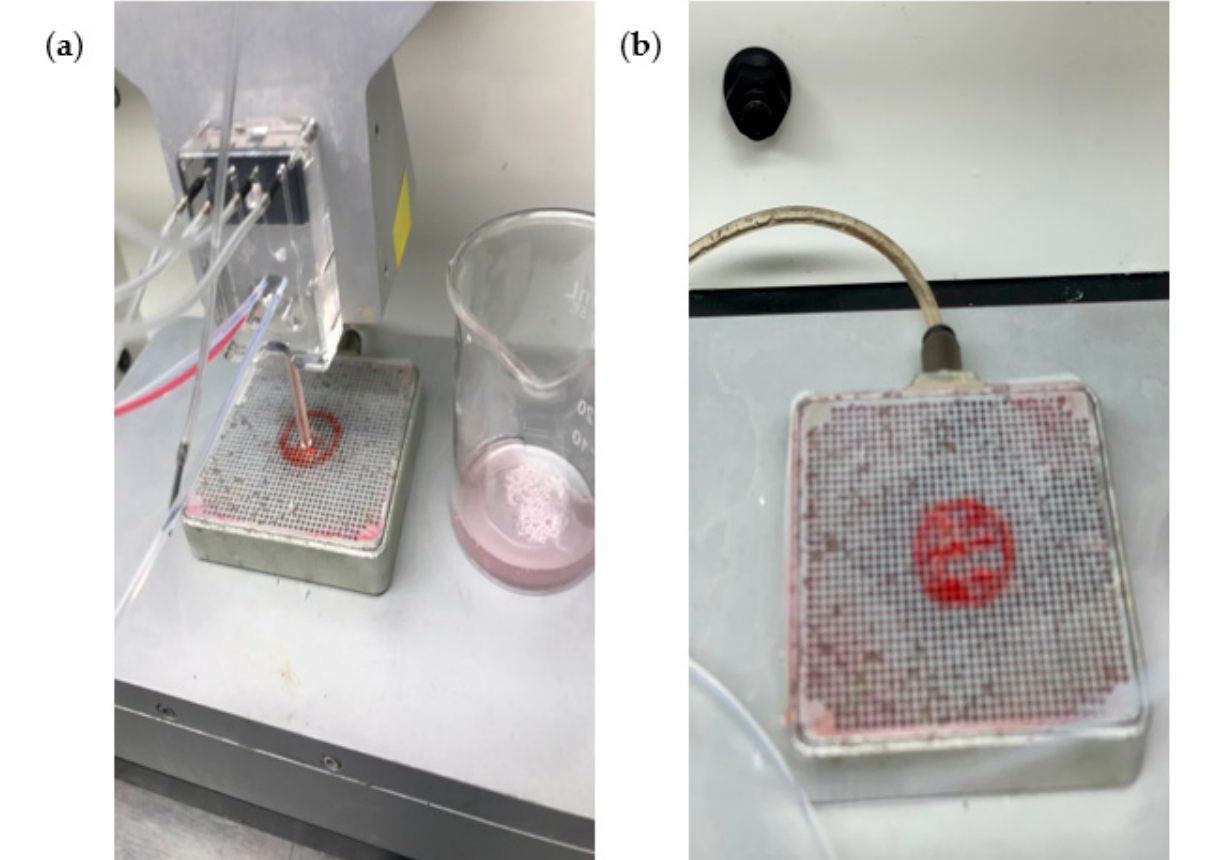
Figure 2. Bioprinted constructs consisting of fibrin-based bioink with phenol red (P3532, Sigma-Aldrich). ( a ) Aspect Biosystems duo-1 printhead printing a construct. ( b ) Bioprinted construct on nylon sheet placed on vacuum chuck showing first few layers of dome-shaped structure.